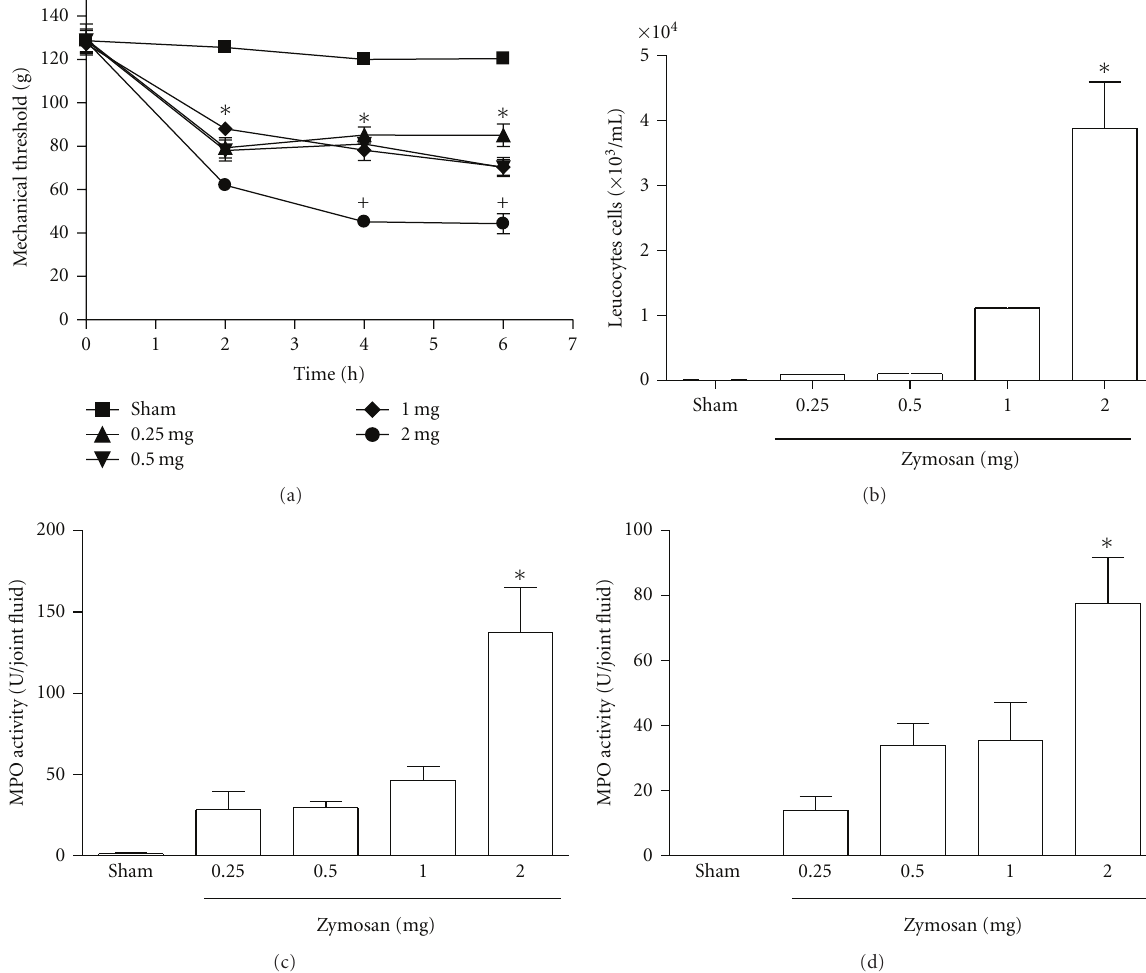
Figure 1: Inflammatoryand hypernociceptive dose-response e ff ect of zymosan-induced TMJ arthritis. Zymosan (0.25, 0.5, 1, or 2 mg; 40 μ L) or saline was injected i.art. into the left TMJ of the rat. The mechanical nociceptive threshold was measured before and after an i.art. injection of zymosan or saline for 6 hours (a). Leukocyte migration was evaluated by cell counting in TMJ fluid (b). MPO activity was evaluated in TMJ fluid (c) and TMJ tissues (d) for 6 h after an i.art. injection of zymosan or saline. Data are expressed as means ± SEM ( n = 6). ∗ P < . 05 versus Sham. + P < . 05 versus 0.25, 0.5, and 1mg groups (ANOVA,